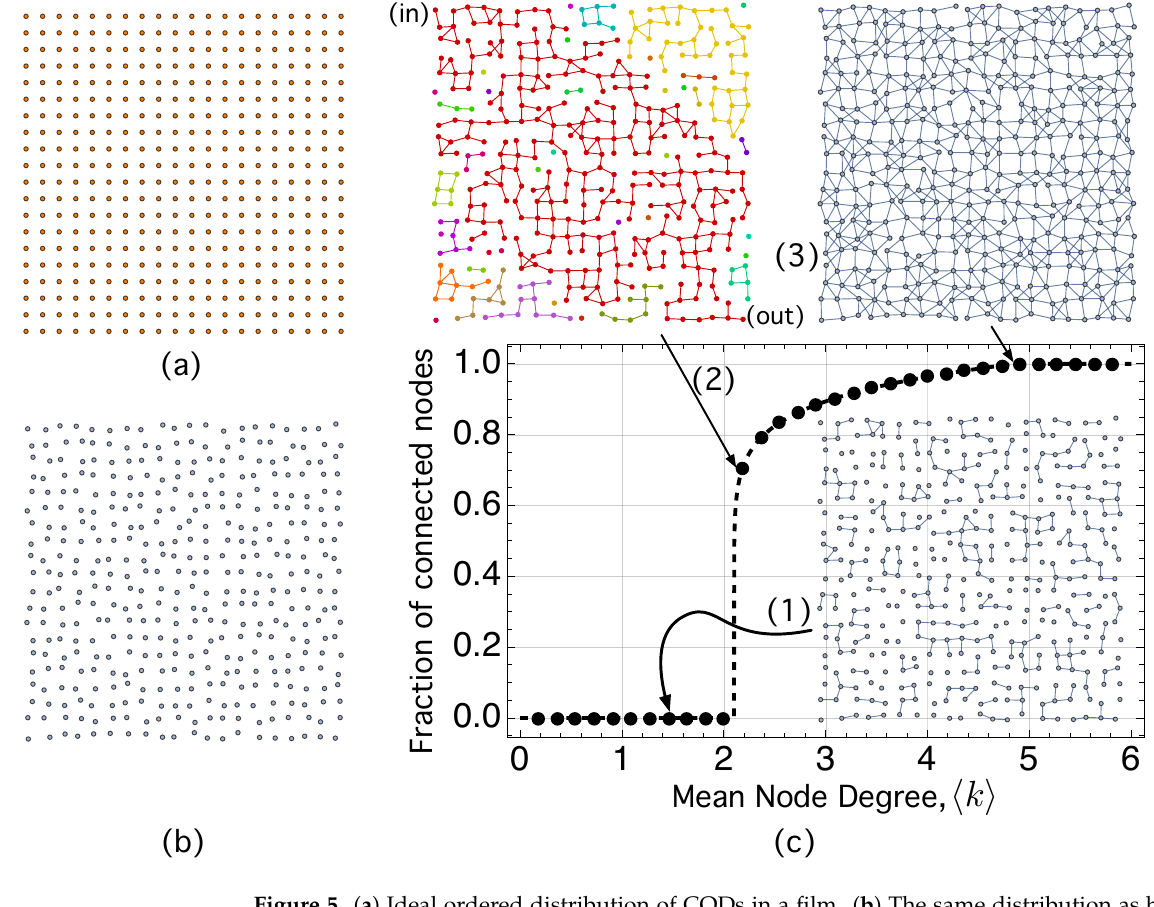
Figure 5. ( a ) Ideal ordered distribution of CQDs in a film. ( b ) The same distribution as before in which disorder has been introduced, as explained in the main text. ( c ) Fraction of connected nodes as a function of the mean node degree ⟨ k ⟩ . The average barrier height ∆ E B fulfills ∆ E B < δε to avoid degradation of transitions LIS → LCS. Insets (1–3) represent the different set of links connecting the nodes in (b) that emerge as the carrier effective mass is reduced. The reason why the link number increases when comparing one network with another is the reduction in m (1) to (3). See the main text for further